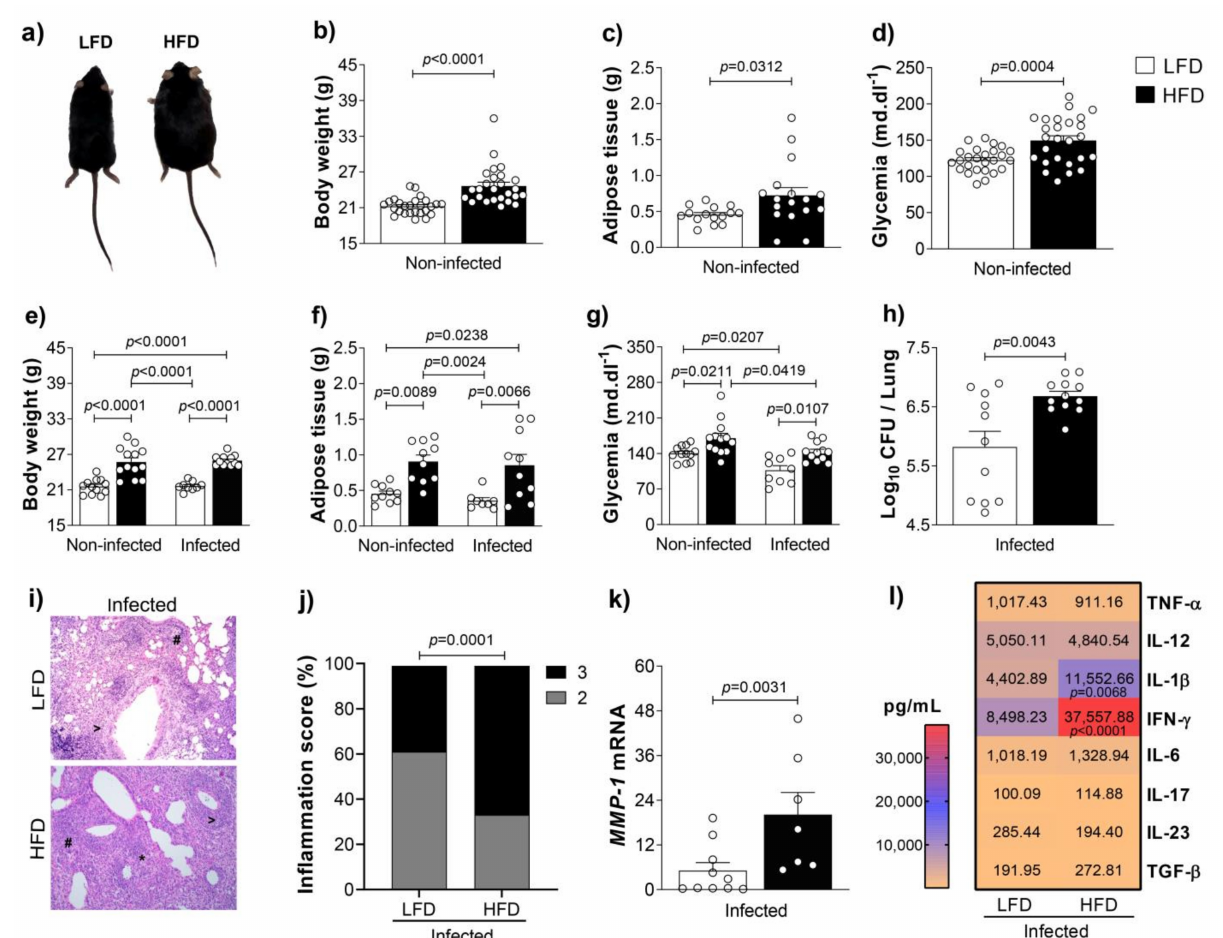
Figure 1. Obesity increases tuberculosis susceptibility. ( a ) C57BL/6 mice were fed with the LFD or HFD for 8 weeks and infected with M. tuberculosis by intra-tracheal (it) route. At 4 weeks post-infection (12 weeks of feeding), lungs were evaluated. ( b ) Body weight, ( c ) adipose tissue weight and ( d ) glycemia before infection ( n = 15–26/group). ( e ) Body weight, ( f ) adipose tissue weight, ( g ) glycemia and ( h ) colony-forming unit (CFU) number in the lungs of lean and obese mice after infection ( n = 8–13/group). ( i ) Representative lung sections stained with H&E (magnification 200 × ) (# perivascular infiltration, > peribronchial infiltration, * foamy macrophages) and ( j ) percentage of inflammation score (2 = moderate; 3 = severe). ( k ) MMP-1 mRNA expression and ( l ) cytokine levels in lung homogenates of lean and obese infected mice ( n = 7–10/group). Data are representative of two independent experiments and are expressed as means ± SD. Bars show the significant difference between groups ( p <